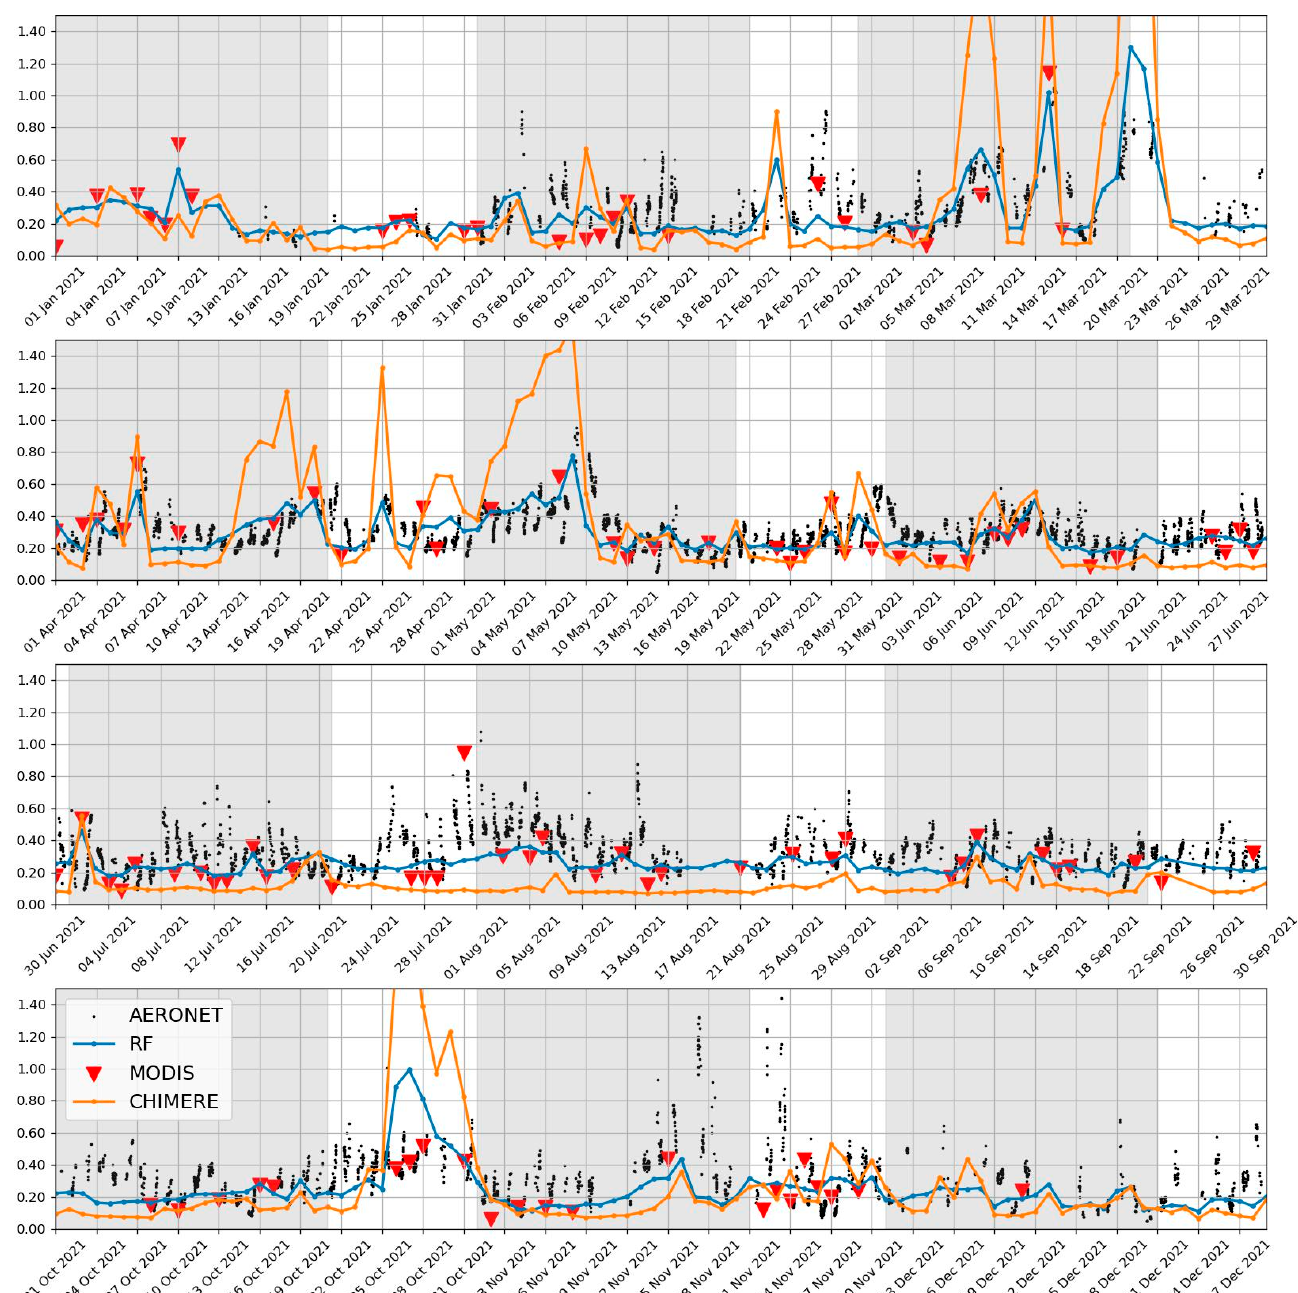
Figure 12. Time series of AOD 550 in Cairo during the year 2021 from AERONET ground-based sun photometer measurements, raw CHIMERE simulations, ML-corrected AODs, and MODIS. The gray areas represent dates used for training the models.